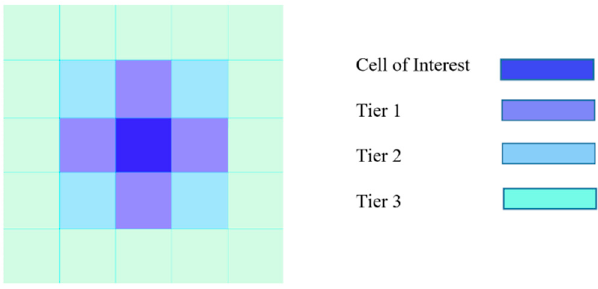
Figure 4. Schematics figure of tiering system.